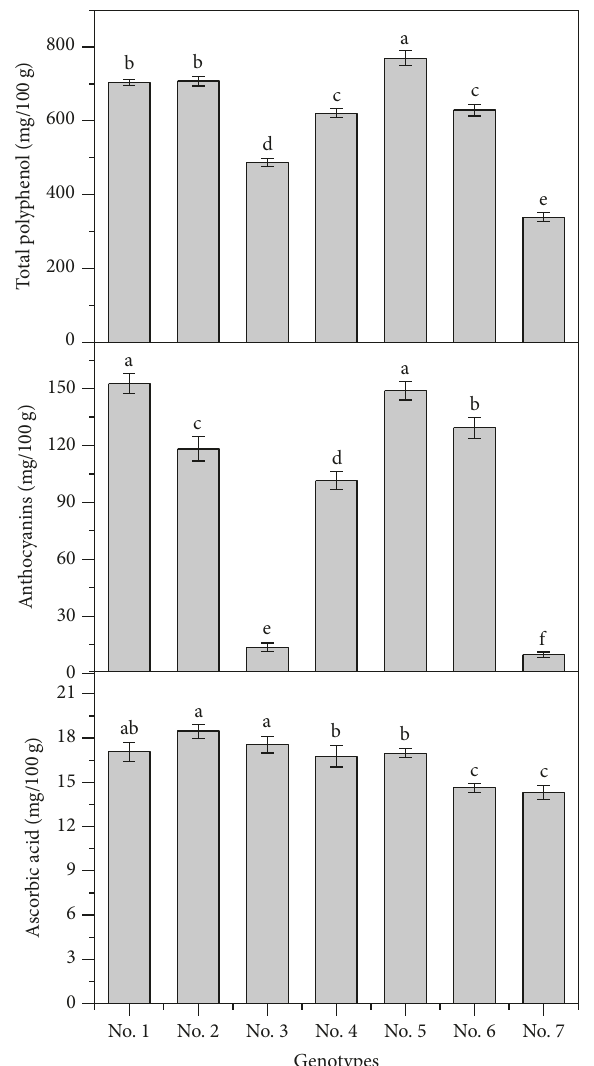
Figure 1: Contents of ascorbic acid , total polyphenols, and antho- cyanins in Chinese dwarf cherry genotypes ( Cerasus humilis (Bge.) Sok.). Numbers 1–7 indicate different genotypes. Different letters indicate significant differences ( 𝑝 < 0.05 ). Data are expressed as means ± SD ( 𝑛 = 3